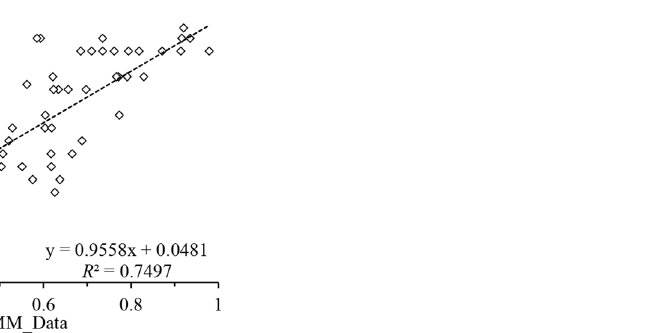
Figure 6. Scatter plot correction between the field-measured and LSMM-estimated vegetation fractions in